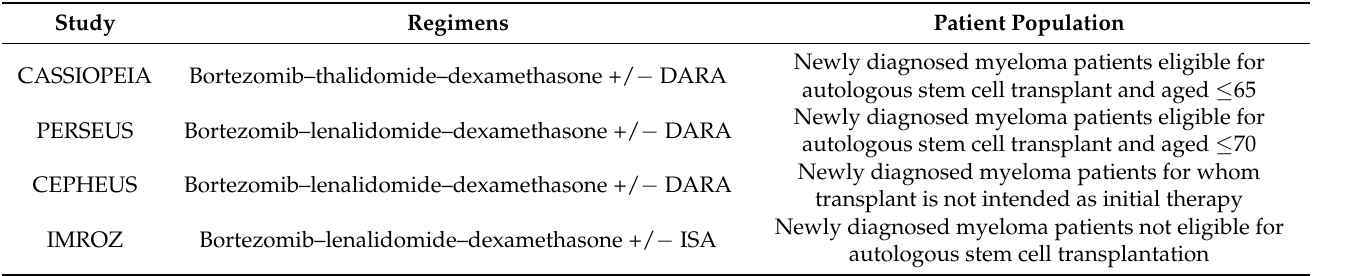
Table 3. Selected phase 3 studies evaluating IMiD + proteasome inhibitor-based antibody